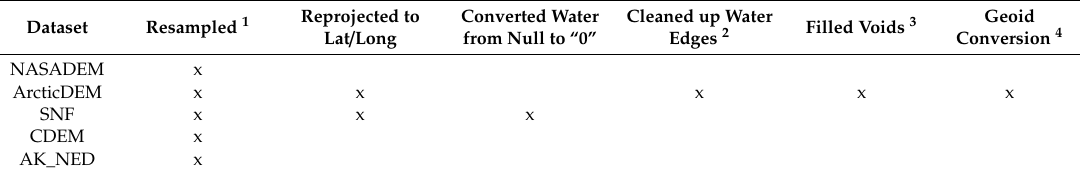
Table 4. Dataset processing steps for each dataset to match Collection-1 DEM standards.